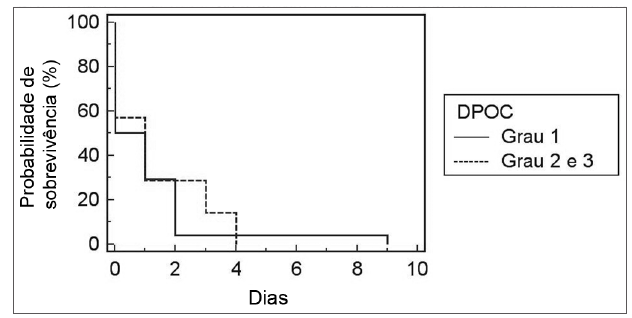
Figura 2. Relação entre o grau de DPOC e tempo de IOT.